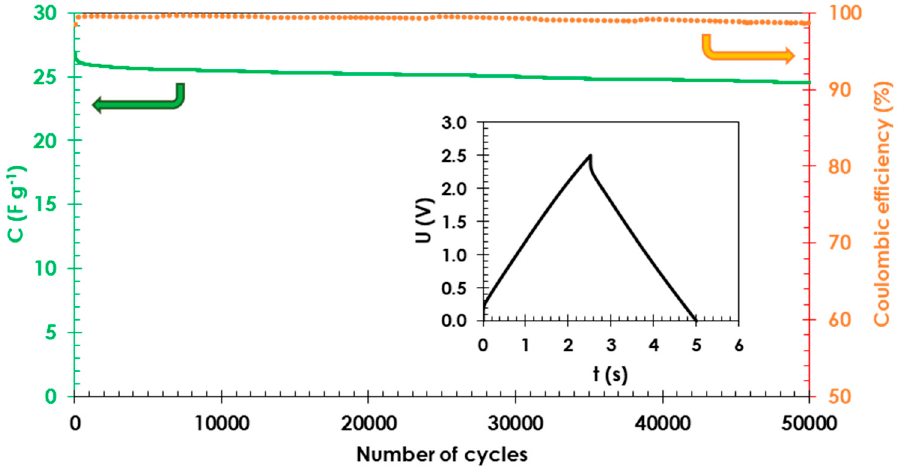
Figure 5. Cyclability of EDLC cells with starch binder in the voltage range from 0.0 to 2.5 V at a current density of 25 A g − 1 and 1 mol L − 1 TEABF 4 in ACN used as the electrolyte. Capacitance values and columbic efficiency are represented as a solid green line and dotted orange line, respectively. Composition of electrode material 80 wt. % activated carbon (YP 80F) 10 wt. % carbon black (Super C65) and 10 wt. % starch.